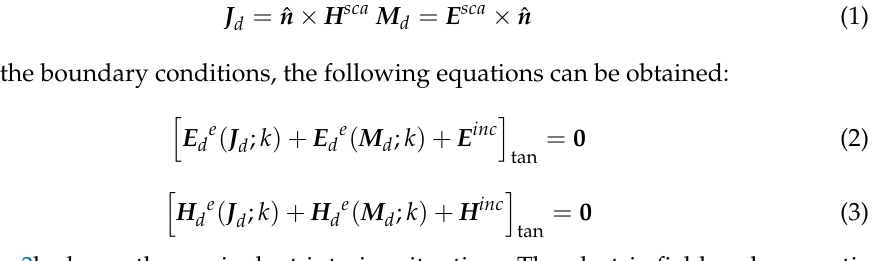
netic field of the region d  of the region d  are the same as that of the region n  . Equivalent electric current and magnetic current as Equation (1).